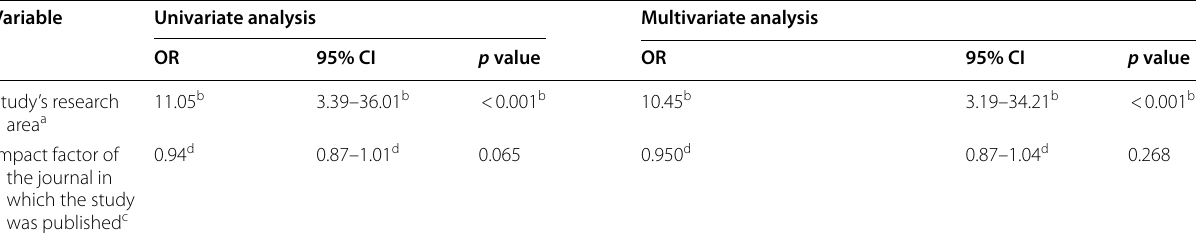
Table 5 Logistic regression analyses on the association of increased workload with a study’s research area and impact factor of the journal in which the study was published, for a non-academic general teaching